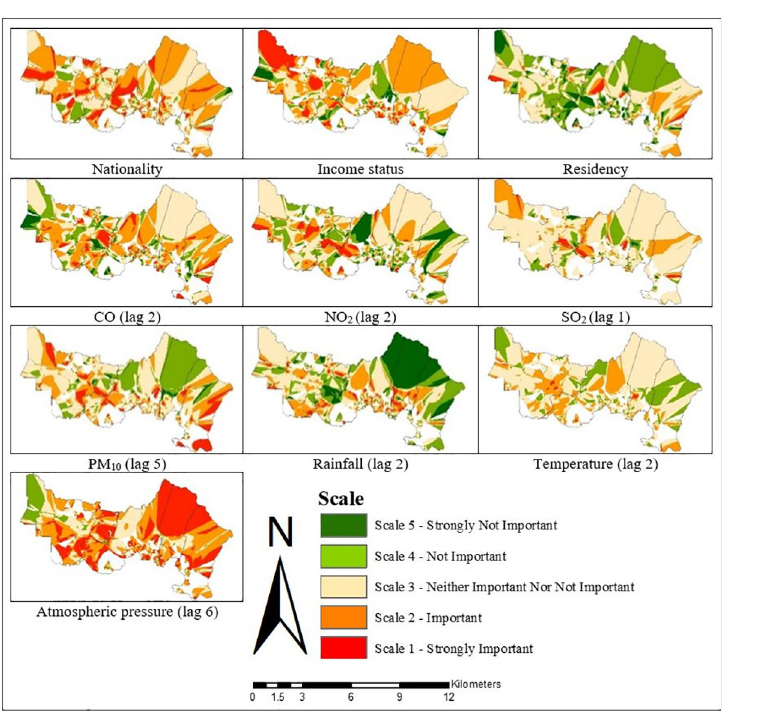
Fig 12. Spatial varying local coefficient estimated for GWR3 in Gombak, 2013 to 2017.